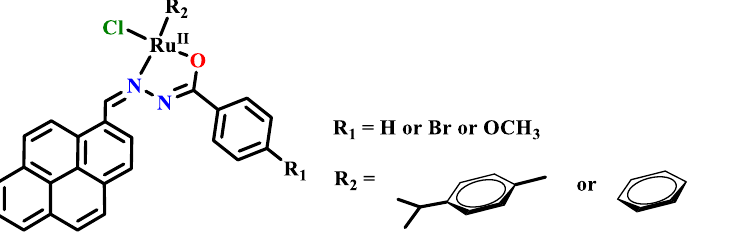
Figure 52. Organo-Ru(II) complexes of pyrene hydrazone with benzamide as a side chain together with benzene or p -cymene as a